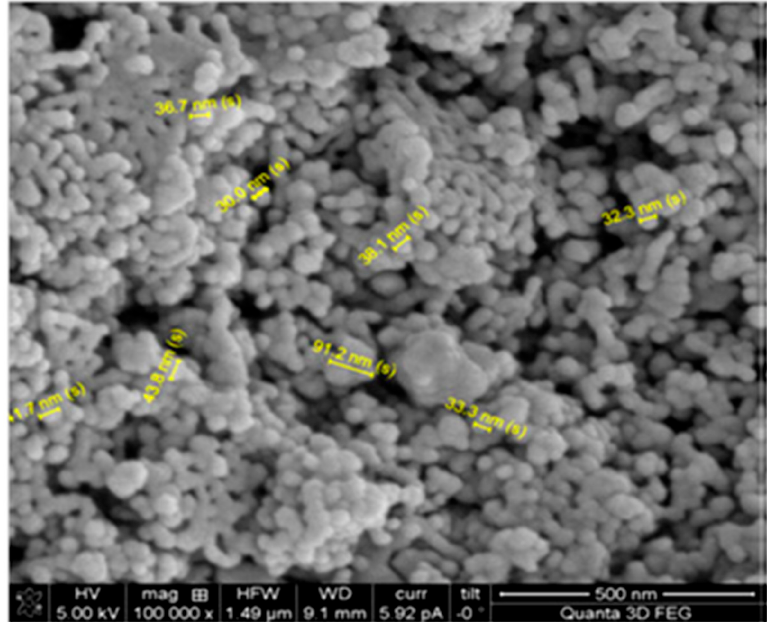
Figure 1. SEM image showing the mesoporous surface morphology of a nickel oxide cathode for DSC, which has been deposited via sintering of nanoparticles with diameter values comprised between 30 and 90 nm (evidenced in yellow). Reproduced with permission from reference [9].